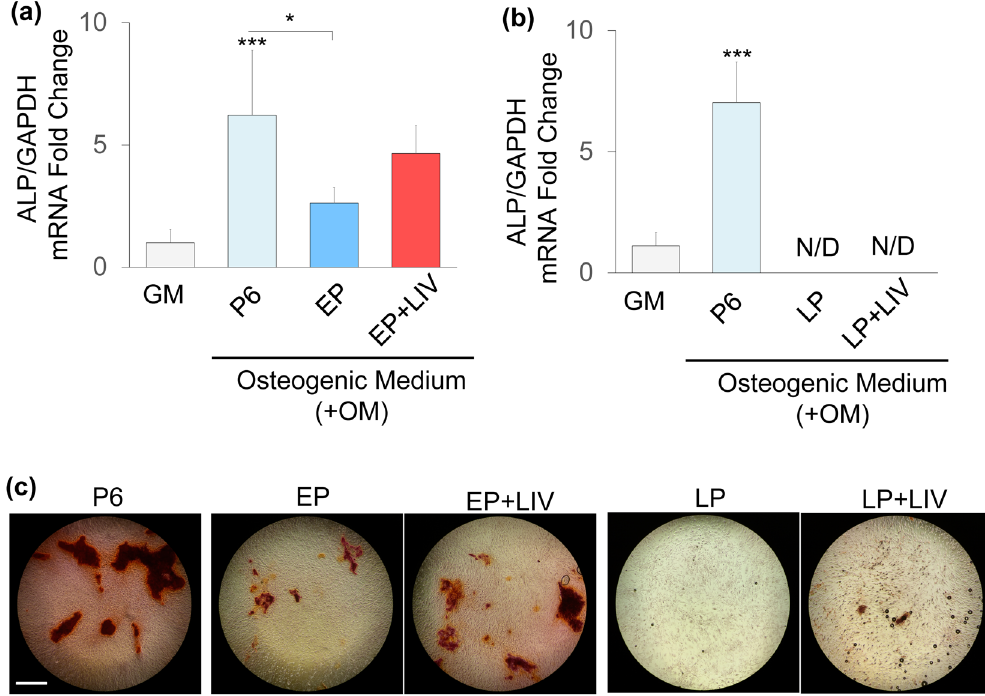
Figure 4. LIV improves osteogenesis at early passage. Alkaline phosphatase (ALP) mRNA expression was quantified and normalized to undifferentiated P6 MSCs kept in growth medium (i.e. GM group was set to 1). ( a ) Comparing to growth medium (GM), osteogenic induction increased ALP mRNA by 6.21-fold in P6 MSCs (p < 0.0001). EP MSCs had ALP mRNA expression of 2.62-fold and was significantly lower than osteogenic P6 control (p < 0.05). ALP expression of EP + LIV MSCs was not significantly different ( − 22%) than the osteogenic P6 control MSCs and remained 4.24-fold higher when compared to P6 MSCs kept in growth medium. ( b ) LP and LP + LIV groups had no detectable ALP mRNA while osteogenic P6 MSCs showed a 7-fold increase when compared to P6 MSCs kept in growth medium. ( c ) After 21 days of osteogenic induction P6, EP and EP + LIV groups were able to form visible calcium deposits. LP and the LP + LIV groups were unable to form visible calcium deposits. Experiments at EP and LP time points were independently run and analyzed. n = 3/grp, group comparisons were made using one-way ANOVA followed by a Newman-Keuls post-hoc test. p < 0.05, ** p < 0.01, *** p < 0.001, against control and each